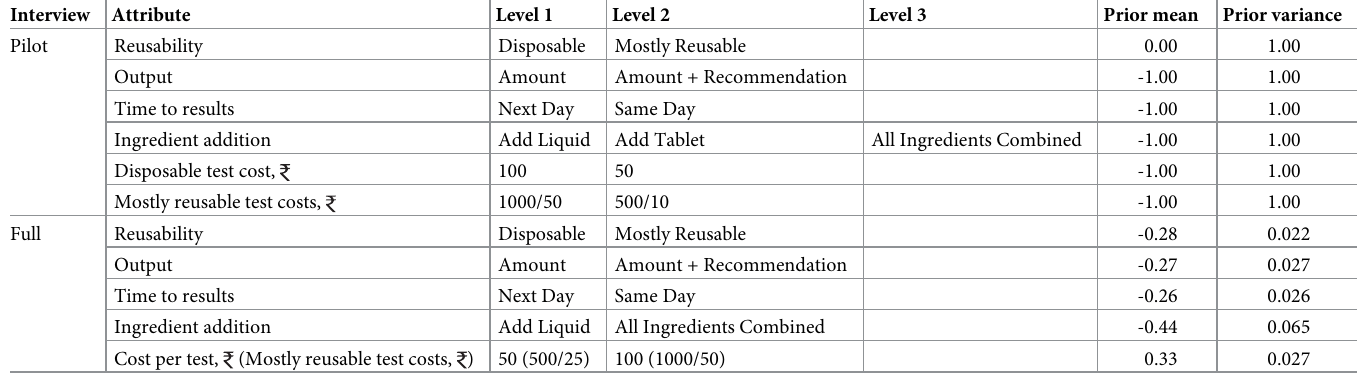
Table 2. Sensor attributes and levels for pilot and full conjoint analysis interviews. Sensor attributes and levels are listed along with the prior mean and variance of Level 1 for each attribute used for generation of the study design as described in the methods section. For pilot interviews, costs for mostly reusable tests are the cost for the reusable component followed by (indicated by ‘/’) the cost for the disposable component. For full interviews, cost per test is the average cost per test over 20 tests, with the mostly reusable test costs also listed as the costs of the reusable and disposable